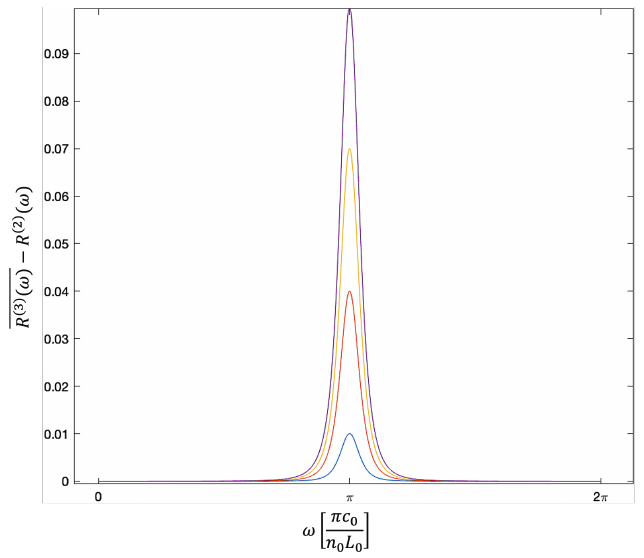
Figure 8. To illustrate the effect of randomly-positioned mirrors on the overall reflection rate of a Fabry-Pérot cavity, the figure shows the dependence of R ( 3 ) ( ω ) − R ( 2 ) ( ω ) in Equation (32) on the frequency ω of the incoming light. Here, | r 0.07 (yellow) and 0.1 (purple). The difference is a small and narrow upwards peak of a certain full width at half the maximum (FWHM) and with an amplitude given by | r